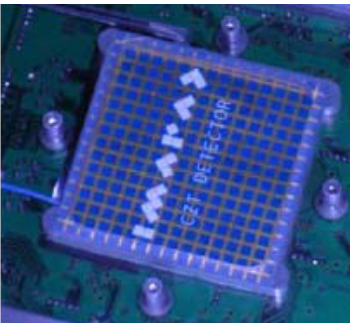
Figure 21. The POLCA CdZnTe